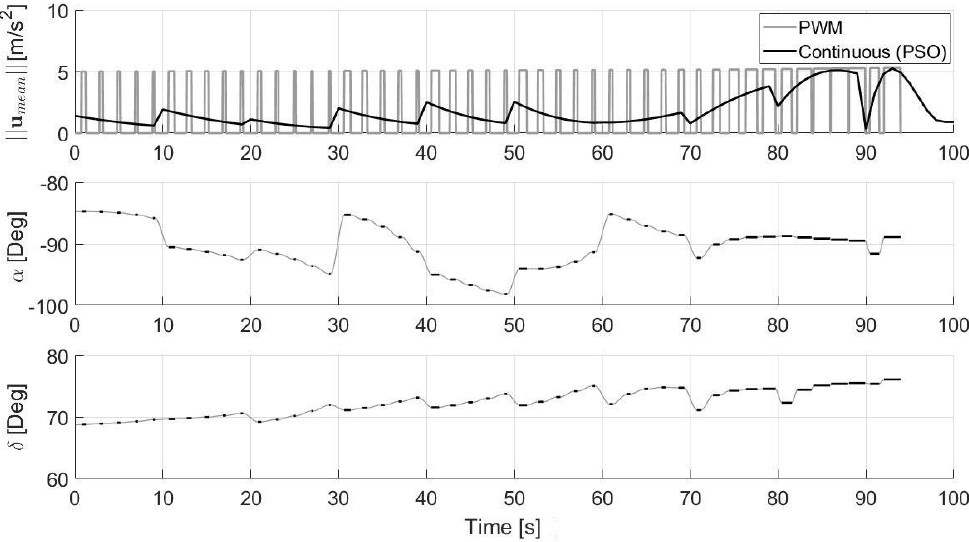
Figure 16. Time-history of commanded acceleration and direction angles with 10 successive